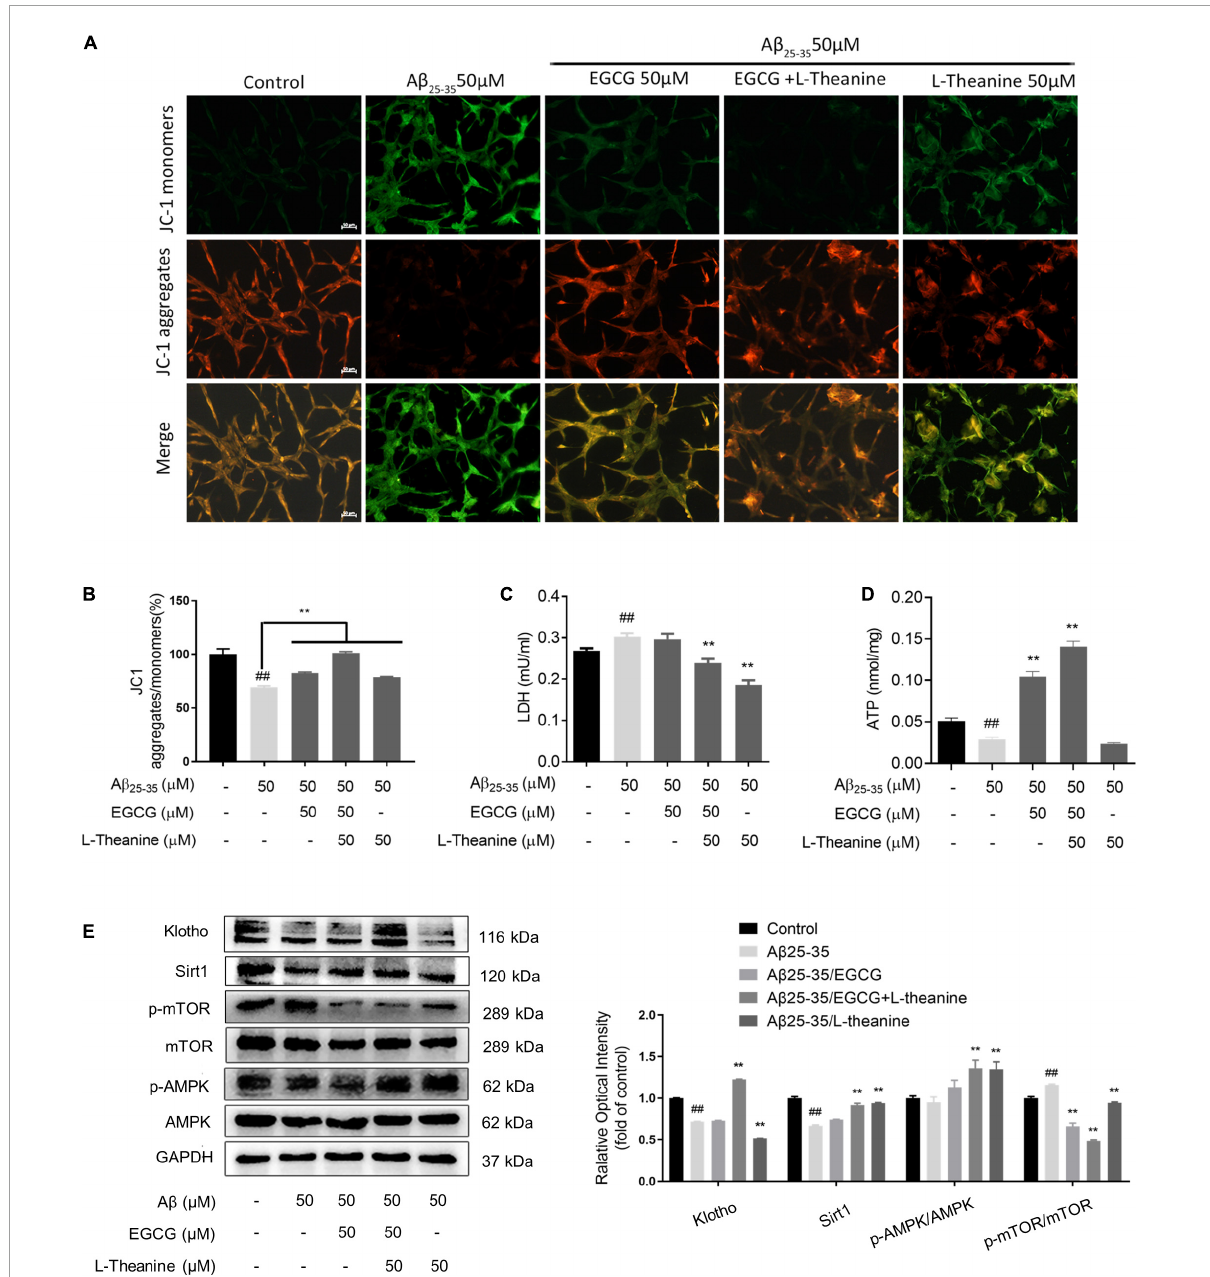
FIGURE5 EGCG and L -theanine synergistically protect mitochondria and promote energy metabolism. (A) JC1 fluorescence staining of mitochondrial membrane potential. (B) JC1 staining statistics (bar = 50 µ m). (C,D) Kit detection of LDH and ATP. (E) The expression levels of proteins related to mitochondria and energy metabolism were detected by Western blotting. ## p < 0.01, compared with control group; ** p < 0.01, compared with A β 25 − 35 group, n = 3.